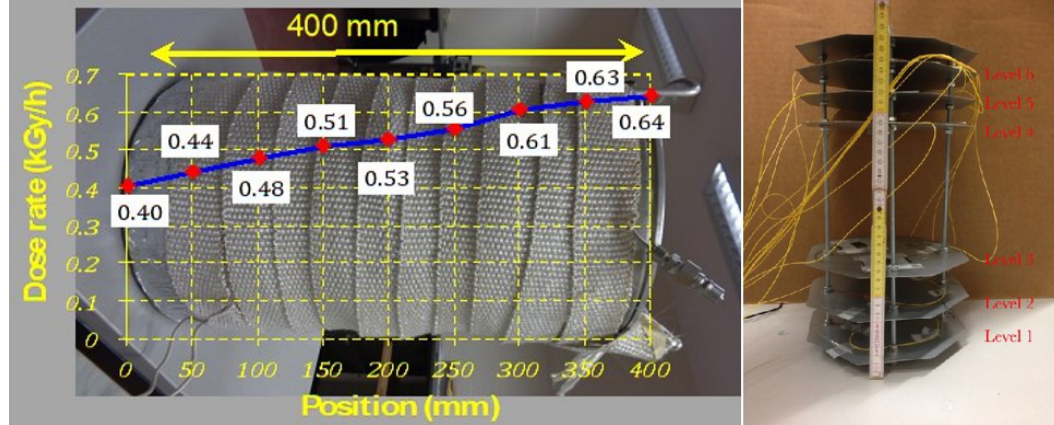
Figure 2. Dose distribution of gamma radiation over the container kGy/h ( Left ). Custom mount, with the CYTOP fibre placed on the 6th level ( Right